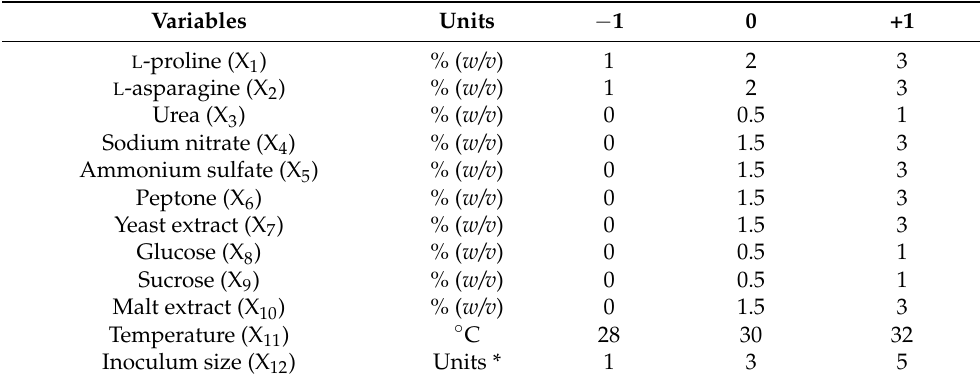
Table 1. Values of the variables employed in Plackett–Burman experimental design. Variables